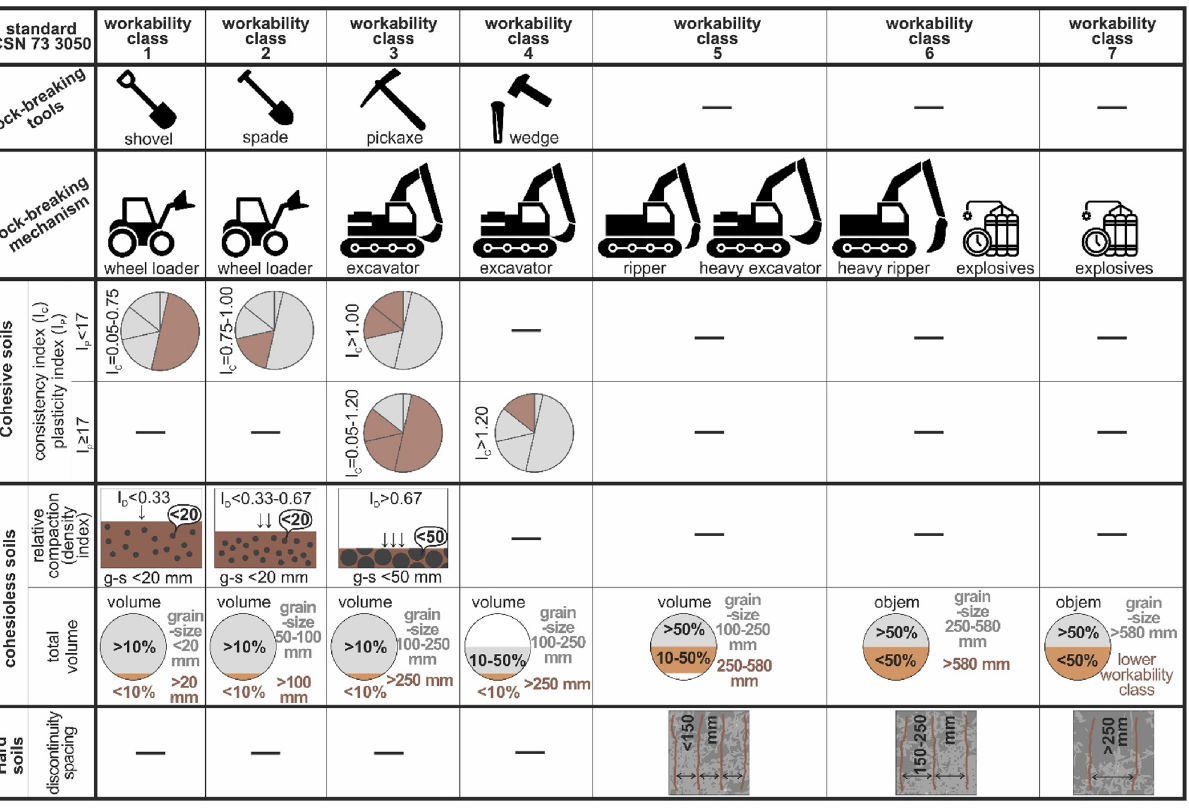
Figure 4. Classification table of soil and rock workability